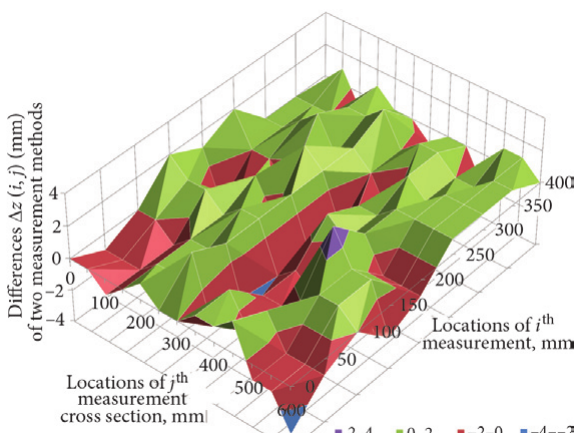
Fig. 9. Measurement differences between stereo vision method and laser distance